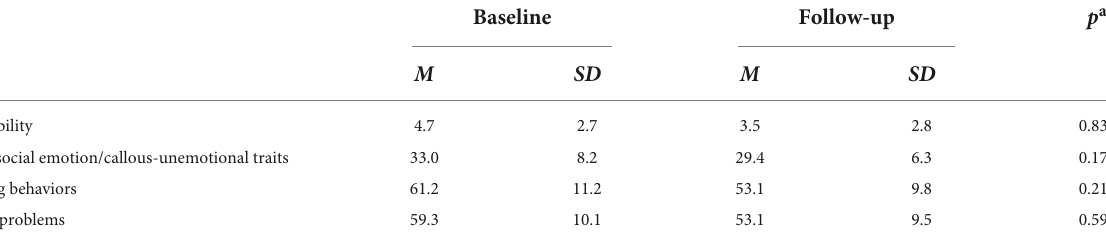
TABLE 3 Baseline vs. follow-up comparisons. Variable